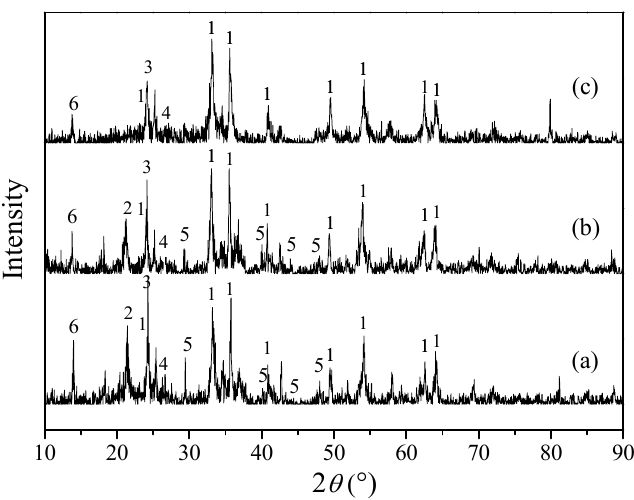
Figure 1. XRD patterns of: ( a ) RM, ( b ) ARM and ( c ) ARM(400). 1: α‐ Fe 2 O 3 ; 2: Fe+3O(OH); 3: anatase (TiO 2 ); 4: quartz (SiO 2 ); 5: calcite (CaCO 3 ); 6: aluminosilicate.